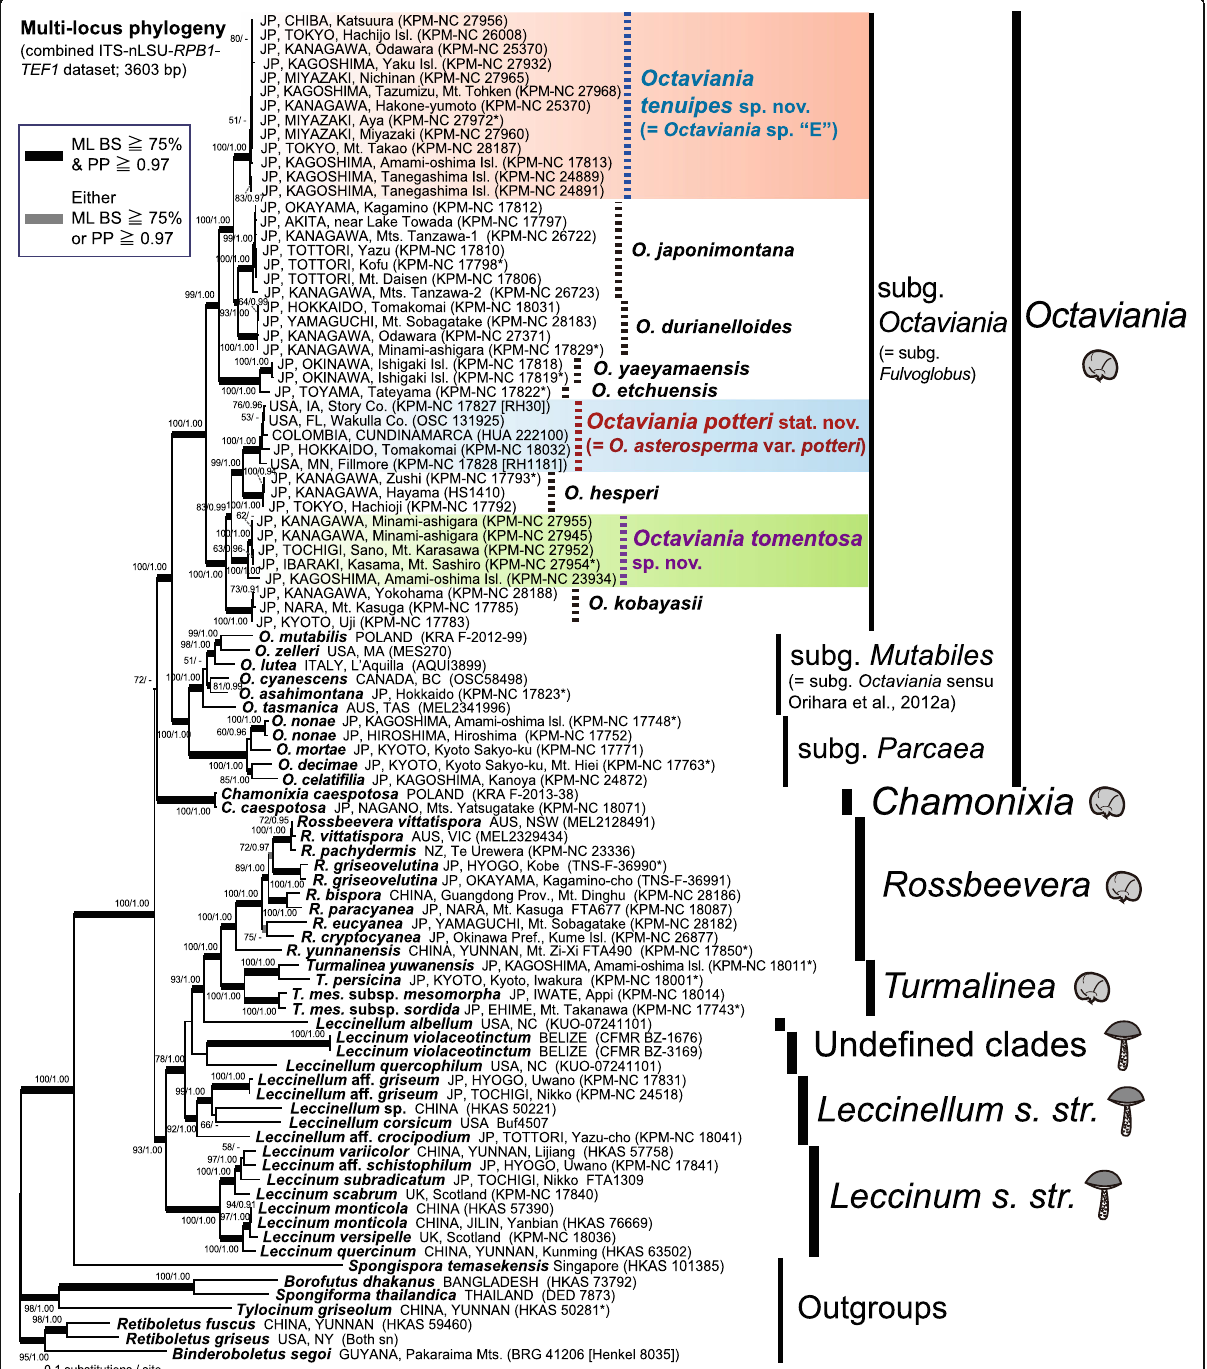
Fig. 1 Maximum likelihood (ML) tree of the Leccinoideae inferred from the multilocus (ITS and LSU nrDNA, RPB1 and TEF1 ) dataset. Branches supported by both BS ≥ 75% and PP ≥ 0.97 and are depicted as thickened black lines. Branches supported by either BS ≥ 75% or PP ≥ 0.97 are shown as thickened gray lines. Statistical values below BS < 50% or PP < 0.90 are not shown. Holotype materials are designated with asterisks (*). Taxa outside of the core clade of Leccinoideae are used as